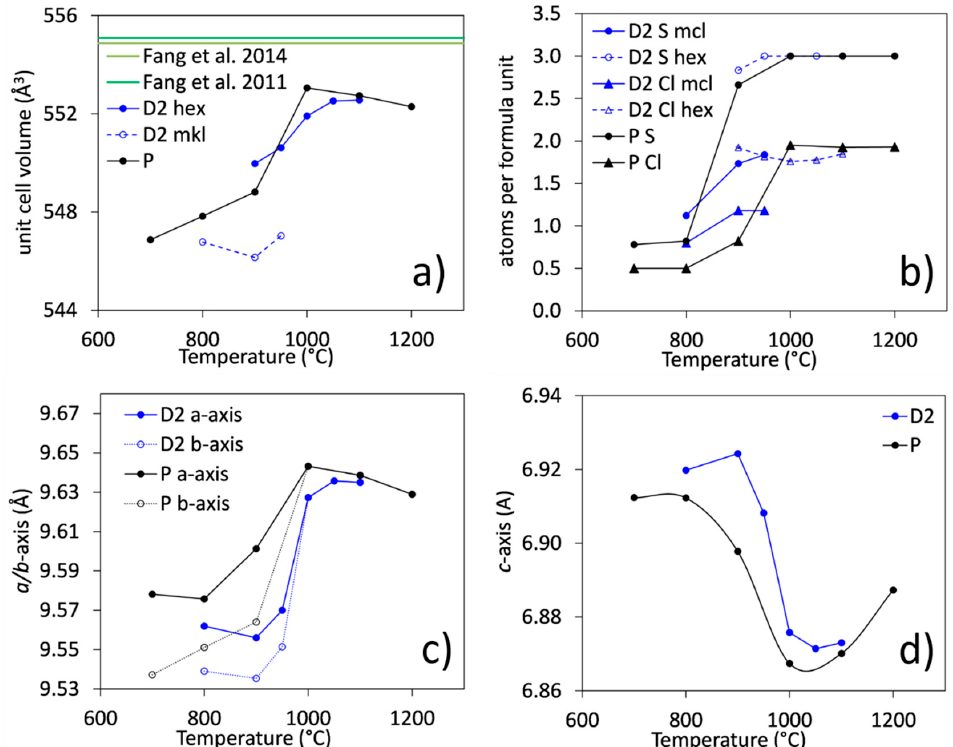
Figure 4. Structural parameters of ellestadite as a function of synthesis temperature (hex = hexagonal, mcl = monoclinic): ( a ) variation of the unit-cell volume of hexagonal and monoclinic ellestadite in sample series D2 and P. For comparison, literature data of Ca 9.82 (SiO 4 ) 3 (SO 4 ) 3 Cl 1.64 [20,21] is shown; ( b ) atoms per formula unit for sulfur and chlorine in ellestadite; and ( c , d ) variation of a-, b- and c-axes in ellestadite with synthesis temperature (700–950 °C: mcl and 1000–1200 °C: hex). The γ -angle in the monoclinic structure varies between 119.94 and 120.05°.